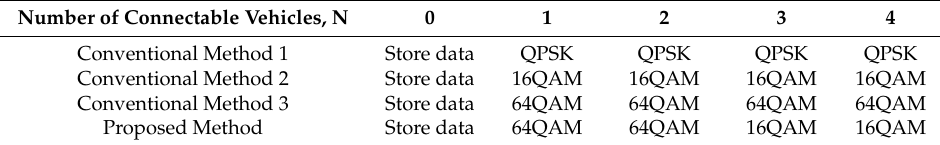
Table 2. Modulation types.